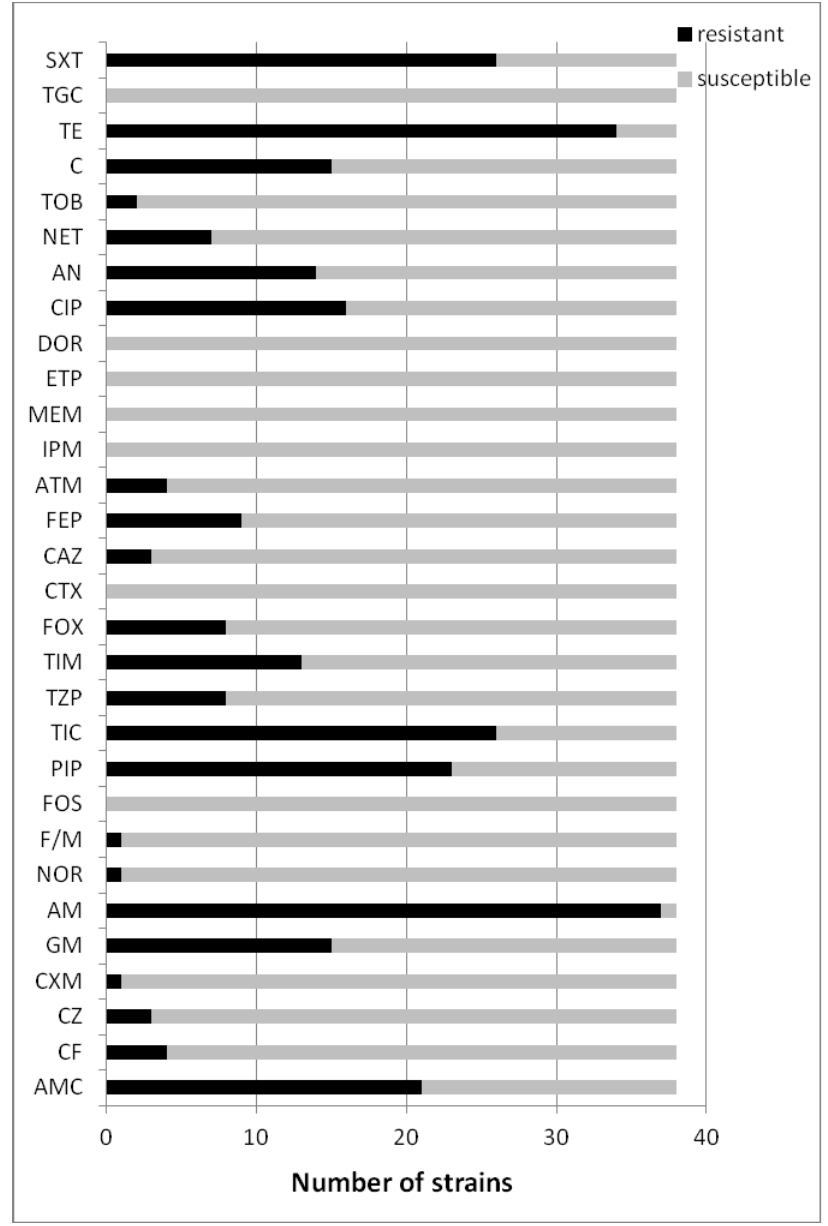
Figure 2. The susceptibility testing of clinical Escherichia coli (ESBL − )